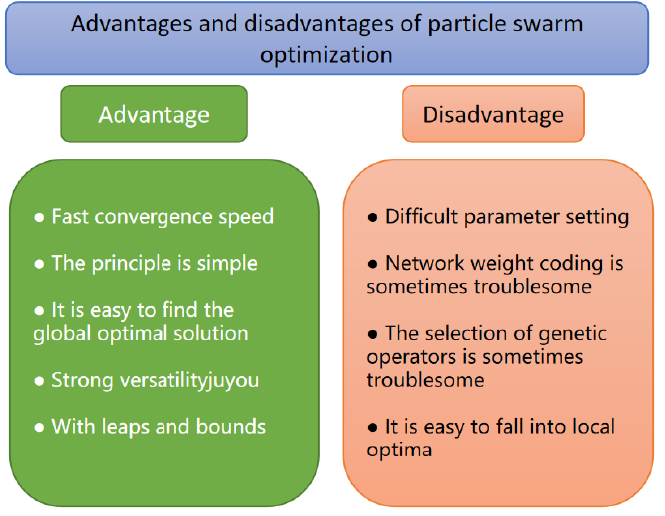
Figure 5. Comparison of advantages and disadvantages of particle swarm optimization.